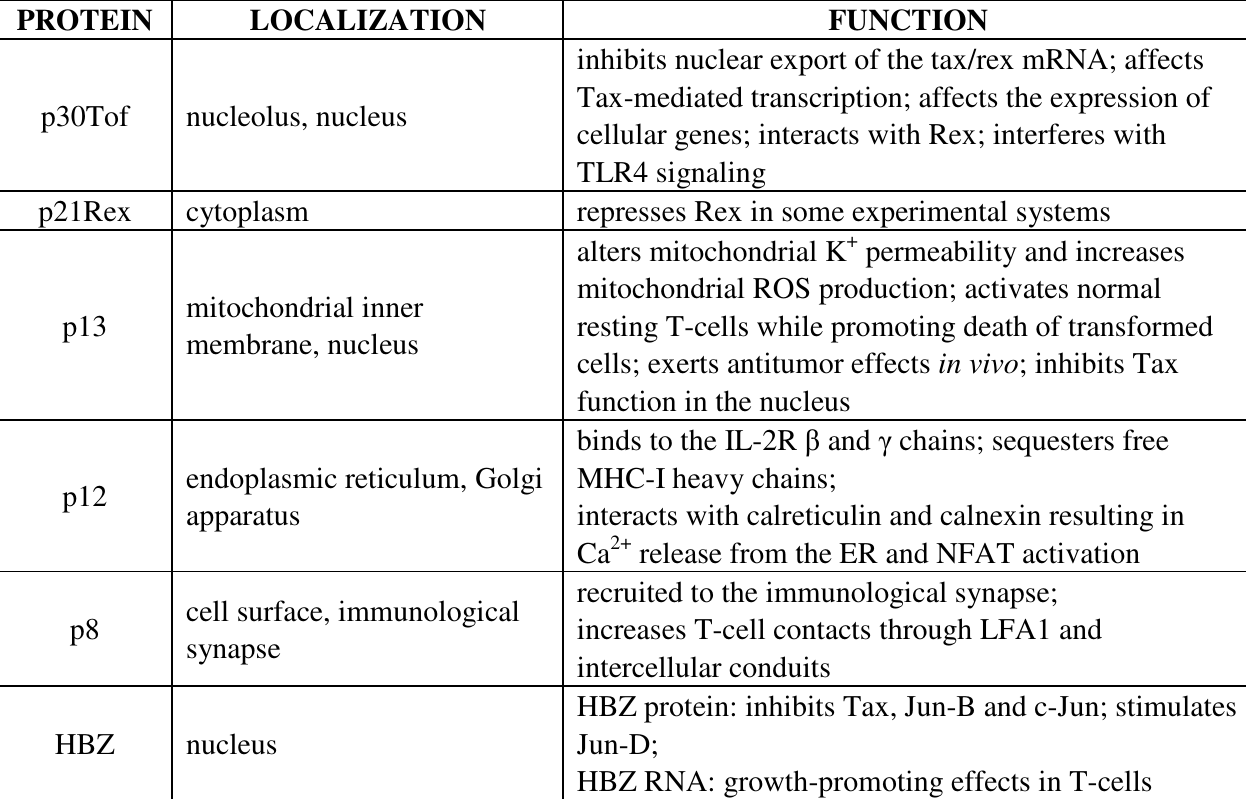
Table 2. Functional characteristics of HTLV-1 accessory